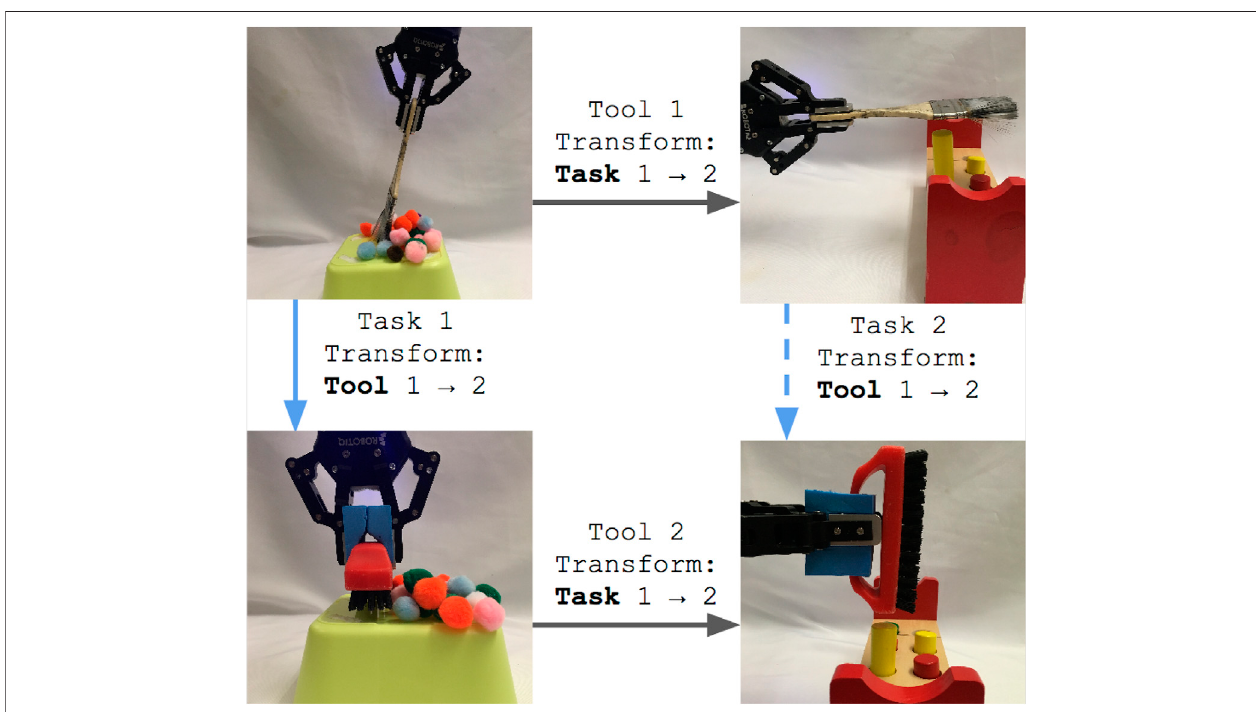
FIGURE15| Correctionsindicate thetransform from tool1 totool 2forthe same task(indicated bythesolid blue arrow). Ourwithin-task transfer evaluation tested whether we can use corrections to suf fi ciently model this relationship. Different tasks may use different tooltips from the same tool (such as the different tooltips used to completetasks1and 2).Ouracross-taskevaluationtestswhetherthetransformlearnedfromcorrections(solidbluearrow)canbereused asthetransform betweenthe two tools for another task (indicated by the dashed blue arrow).